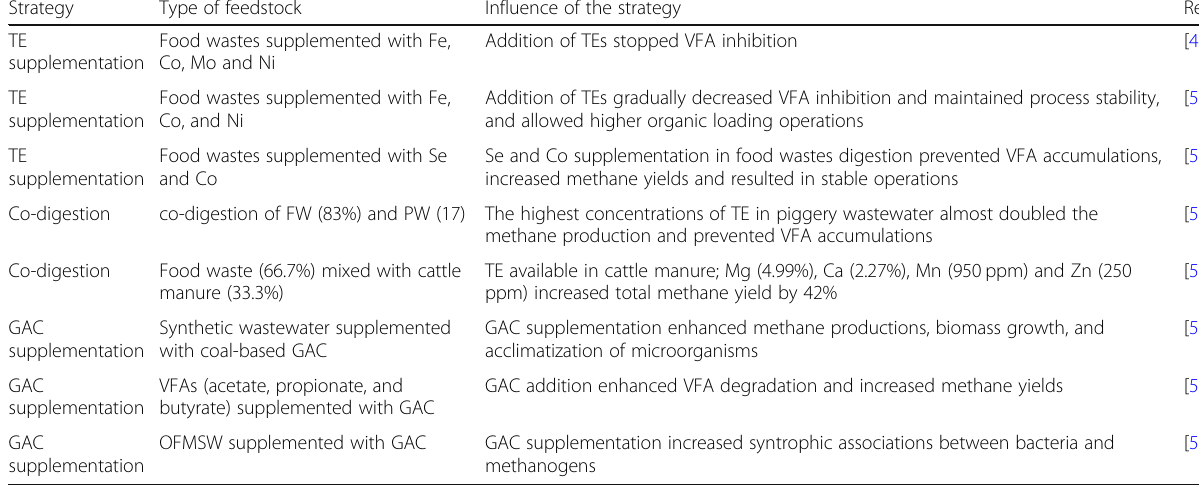
Table 4 Summary of results from trace elements and granular activated carbon supplementation in the anaerobic digestion process Strategy Type of feedstock Influence of the